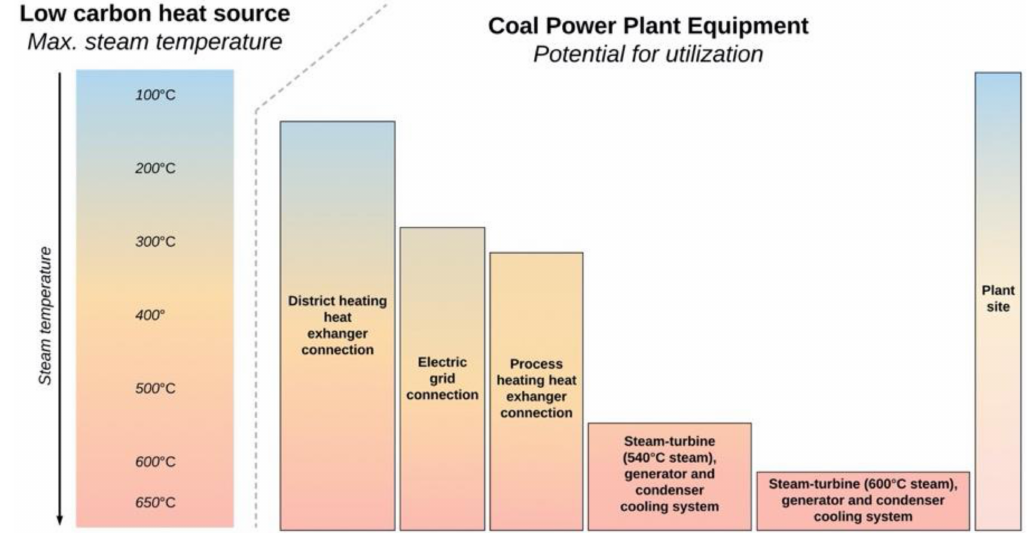
Figure 8. Re-utilization potential of coal plant assets based on maximum live steam temperature available from a low-carbon heat